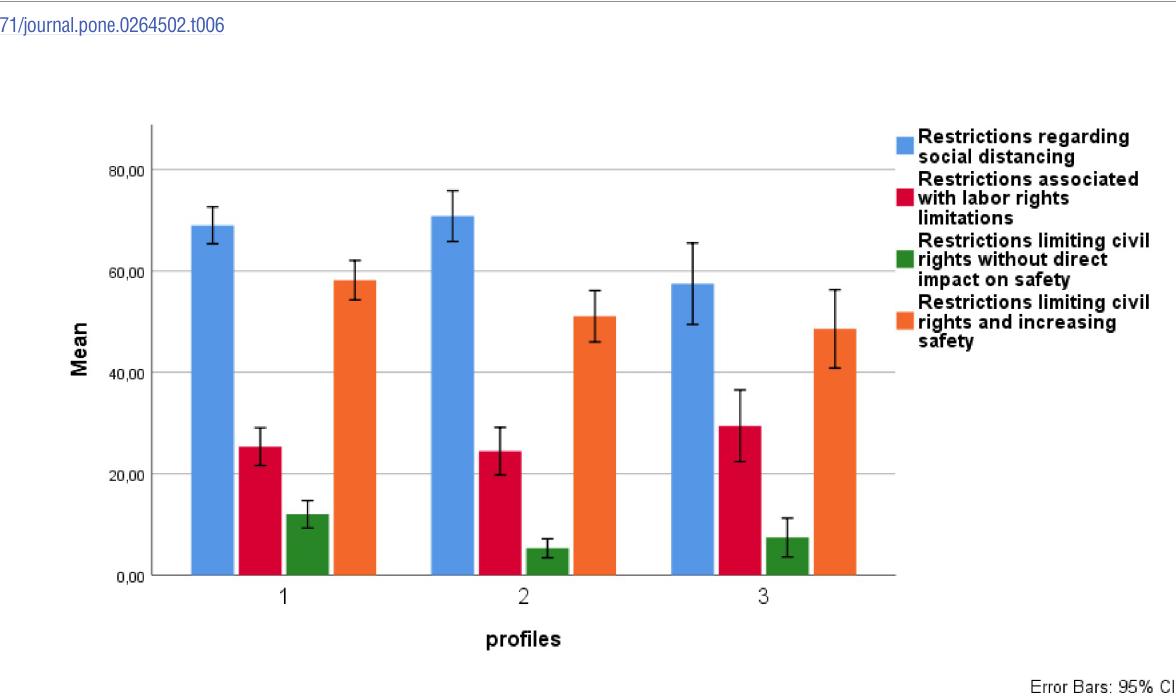
(F2—restrictions associated with the limitations of labour rights and F3—restrictions limiting civil rights without a direct impact on safety) in reducing the probability of contagion. Gener- ally, the participants endorsed the restrictions from the F1 (regarding social distancing and iso- lation) and F4 (limiting civil rights and increasing safety) groups more than those from the remaining groups. For the F1 group of the restrictions (social distancing and isolation), the variability of scores was relatively the lowest as there was a consensus among the participants that these limitations were necessary to stop the pandemic.